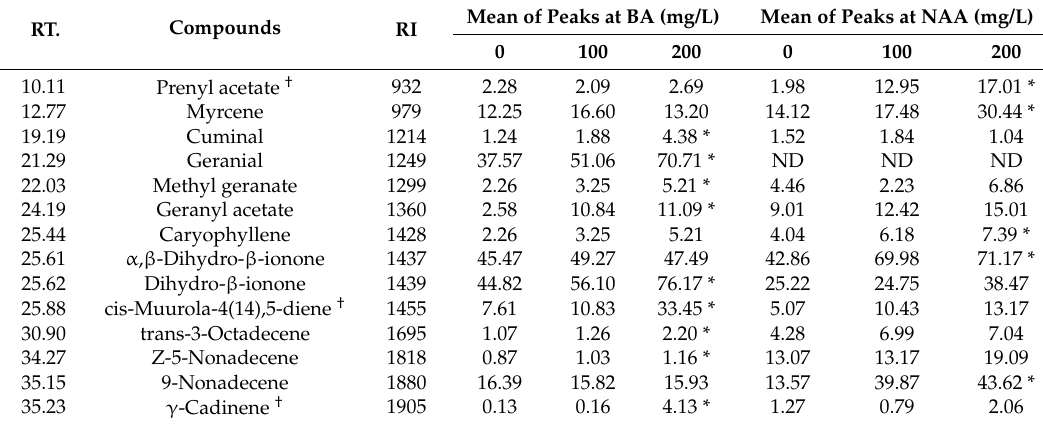
Table 2. Identification of VOCs that differed significantly ( p ≤ 0.05) between flowers of Hybrid Tea after being treated with different concentrations of BA and NAA. RT. Prenyl acetate